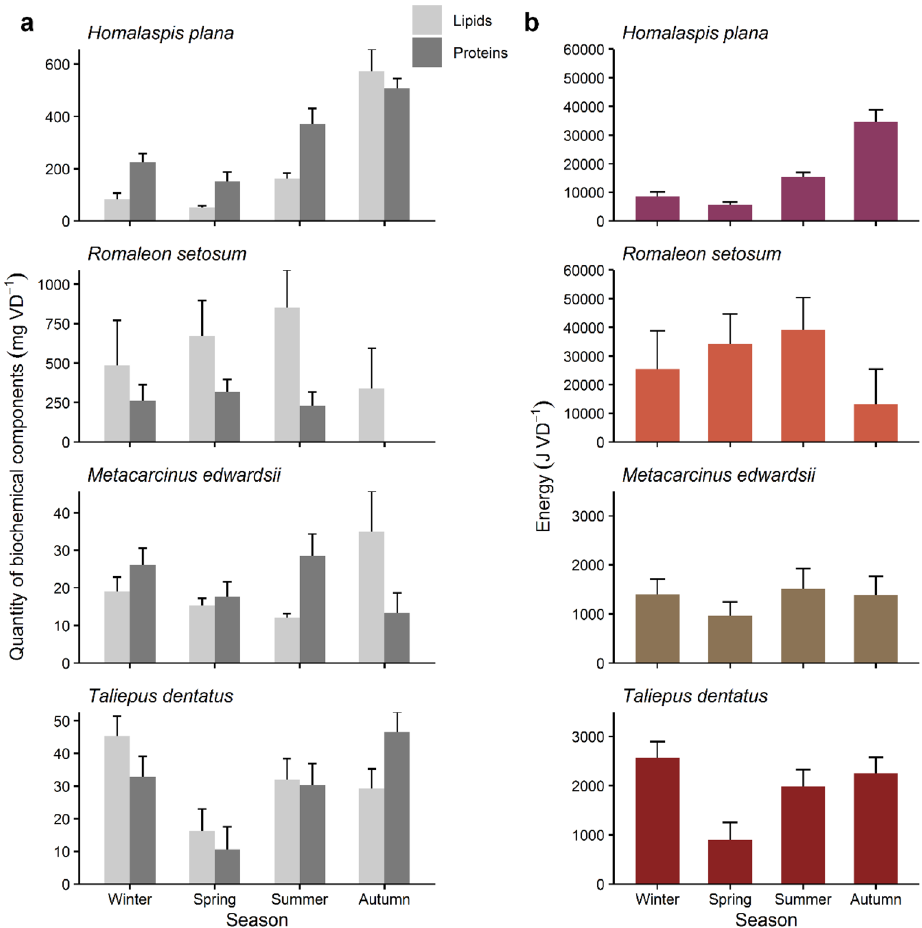
Figure 2. Seasonal pattern of biochemical components and energy present in the paired vasa deferentia of the four brachyuran species studied. ( a ) Quantity of proteins and lipids. Note different scale for each species. Values correspond to adjusted means + SE in all species, except for quantity of proteins and lipids in Homalaspis plana and lipids quantity in Metacarcinus edwardsii which correspond to means + SE . Seasons correspond to austral seasons. ( b ) Energy content. Note different scales of energy investment of H. plana and R. setosum , and M. edwardsii and Taliepus dentatus . Values correspond to adjusted means + SE in all species, except for in H. plana which correspond to means + SE . Energy content was estimated by converting amounts of lipids and proteins to their caloric equivalents. Seasons correspond to austral